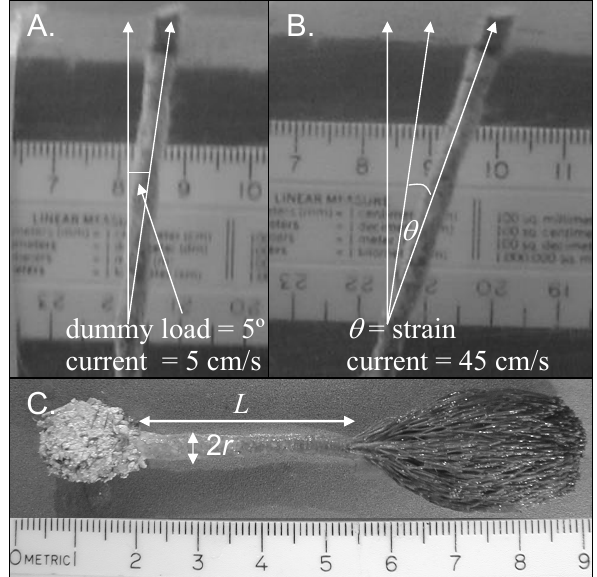
Fig. 9. (A) Decapitated Penicillus capitatus alga pre-strained to 5 ◦ deflection with the dummy load (current velocity=5cm/s). (B) De- capitated P. capitatus alga strained beyond the 5 ◦ pre-strain dummy load (current velocity=45cm/s). Angles of deflection ( θ ) be- yond the 5 ◦ pre-strain were employed in the stress-strain analyses. (C) Photograph of a P. capitatus alga depicting the length ( L) and radius ( r) dimensions employed in modeling its thallus as a can- tilever beam. From Ries